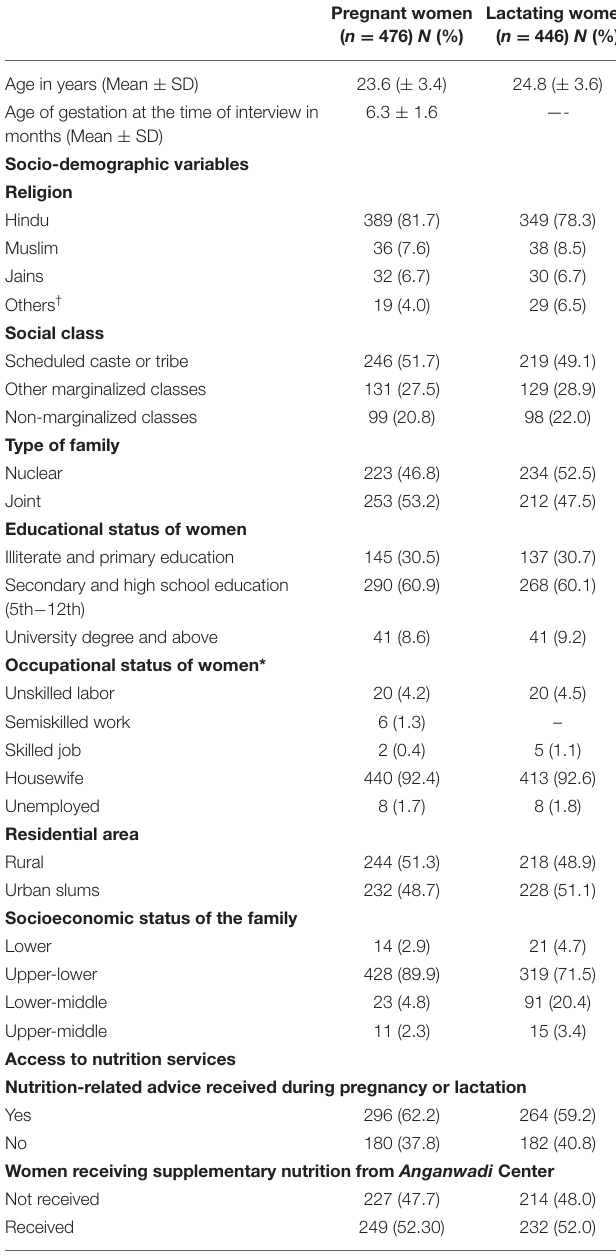
TABLE 1 | Participant’s socio-demographic characteristics by groups ( n = 922). TABLE 2 | Factor loadings for food groups that loaded highly (| > 0.30|) in Varimax